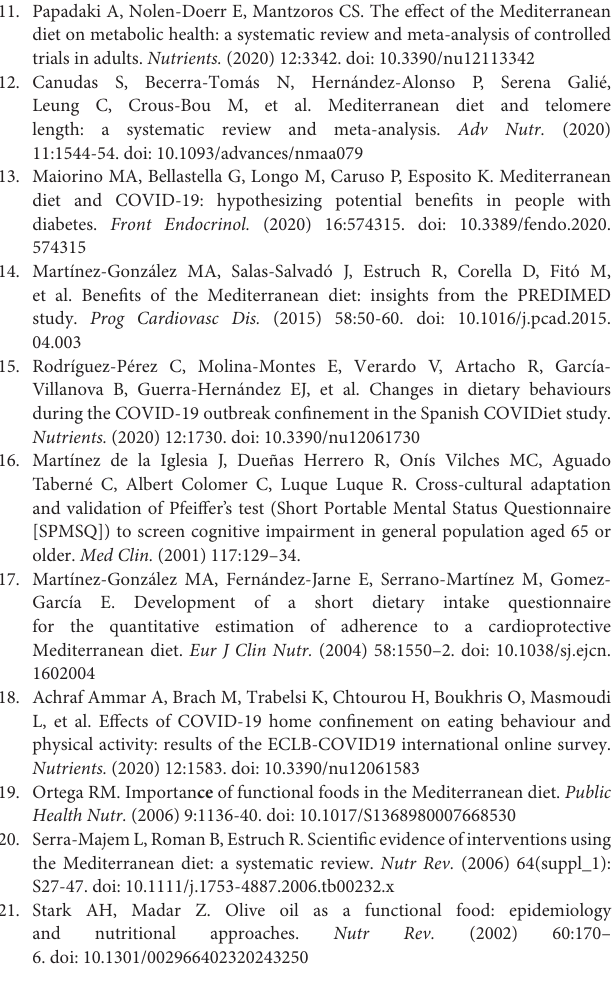
Taberné C, Albert Colomer C, Luque Luque R. Cross-cultural adaptation and validation of Pfeiffer’s test (Short Portable Mental Status